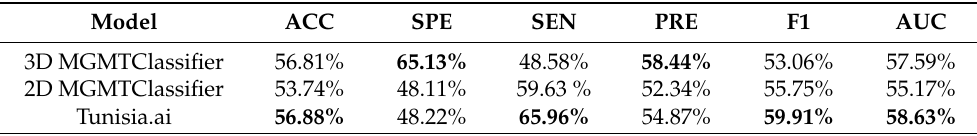
Table 5. 5-fold CV performances of models trained and tested on dataset A+B . The input sequence is KBF for both the 3D and 2D MGMTClassifier models and T1-w CE for the Tunisia.ai one. For each metric, the best value is reported in